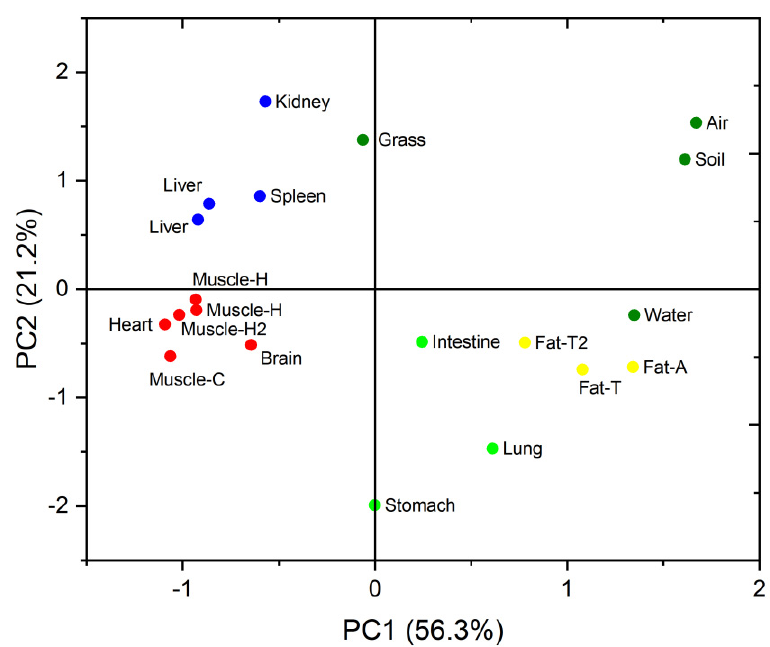
Figure 3. Two-dimensional principal component analysis score plot for the polybrominated diphenyl ether concentrations in the sheep tissue samples.